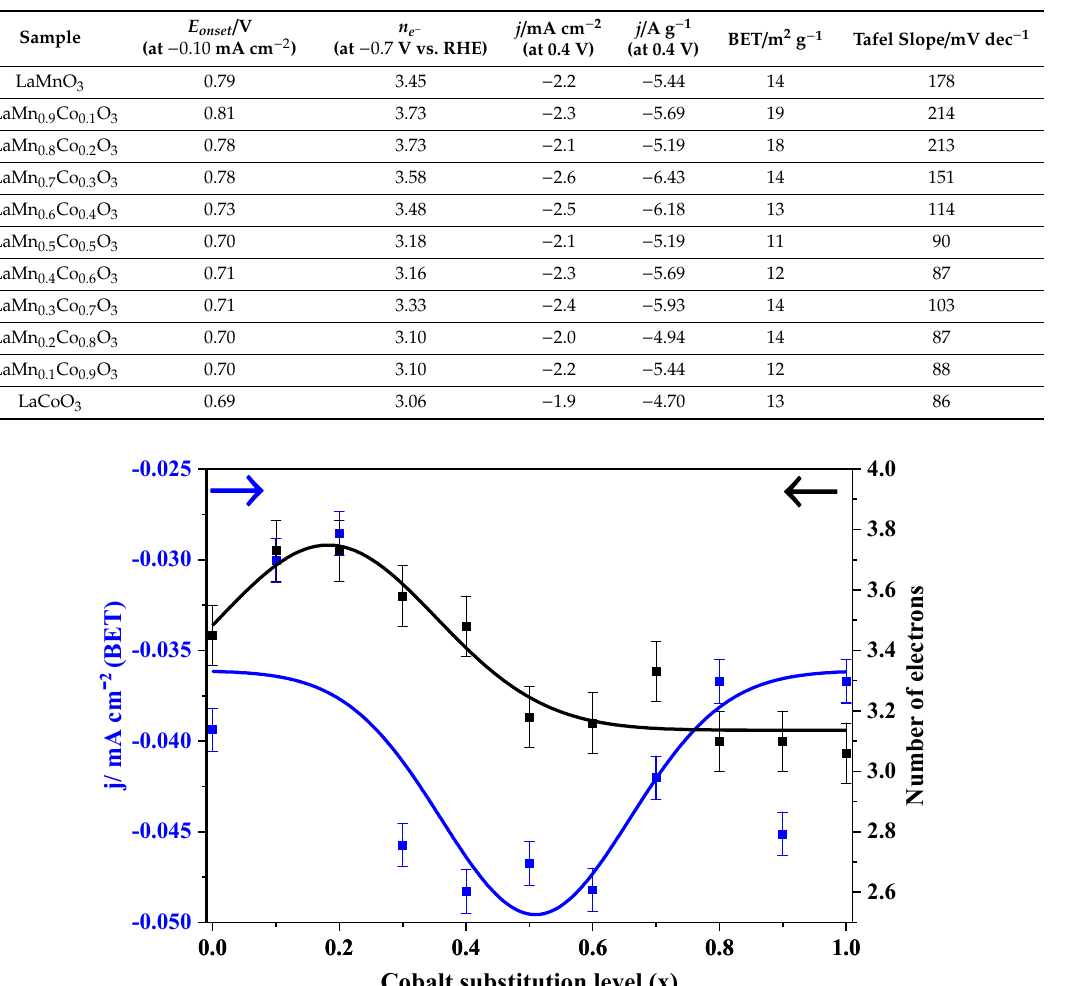
Table 1. Onset potential, number of electrons, limiting current density at 0.4 V, Branauer–Emmett–Teller (BET) surface area, and Tafel slope obtained for the oxygen reduction reaction (ORR) at di ff erent perovskite materials.